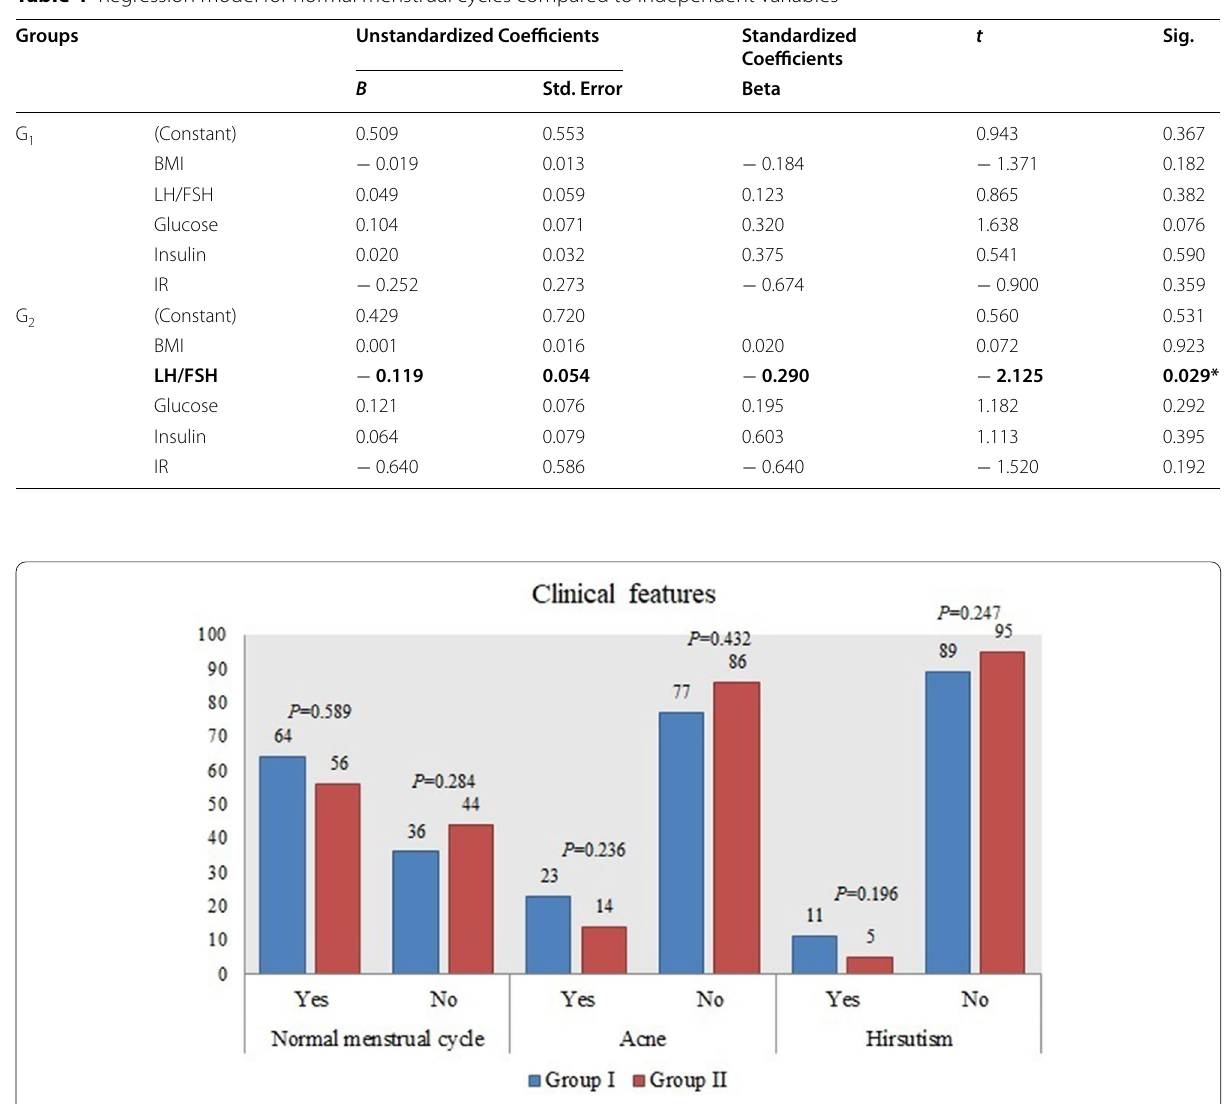
Fig. 2 Observed individual parameters including menstrual cycle, acne, and hirsutism in the study